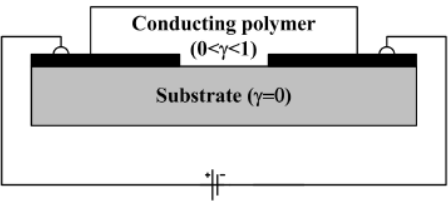
Figure 6. Chemiresistor configuration: The electrical resistance change resulting from a change in the gas concentration is measured between two electrodes [69], where is the normalized gas concentration.